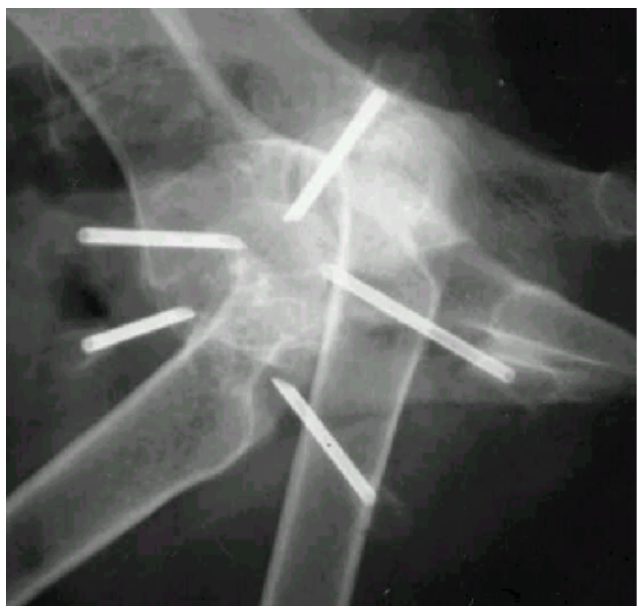
Figure 3. Fluoroscopic evaluation during placement of the needles.